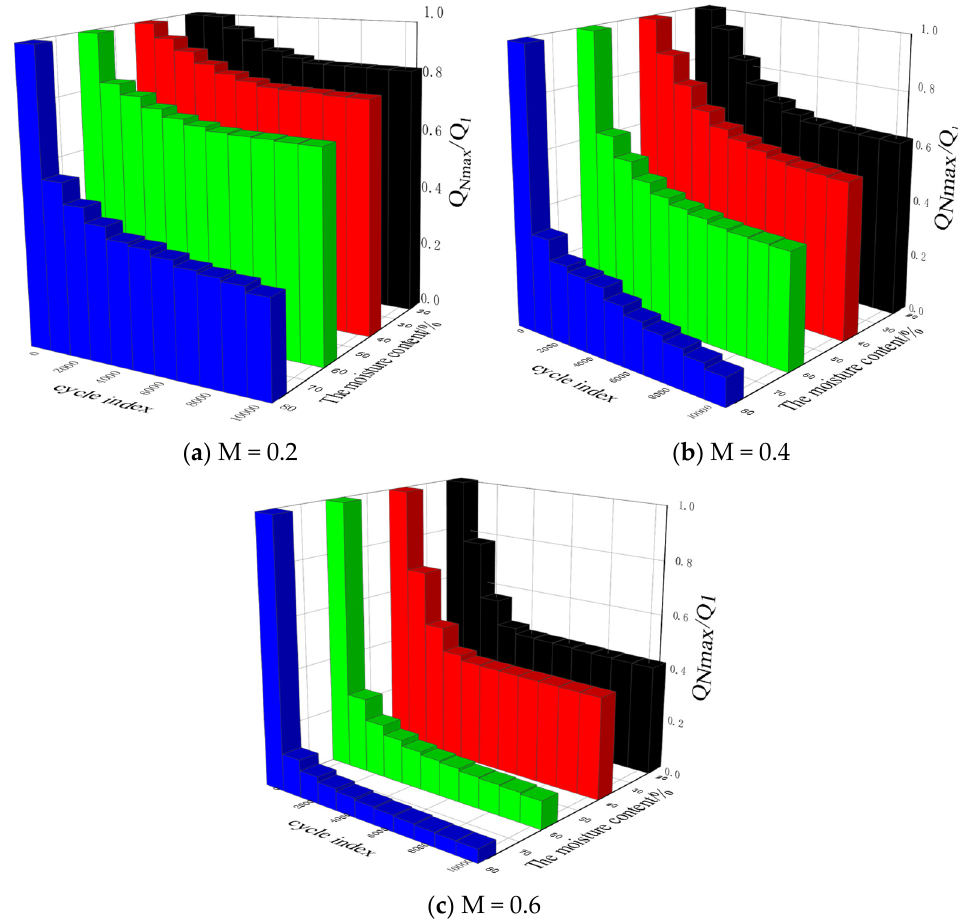
Figure 11. The variation in the pile lateral friction with the number of cycles under different water contents. ( a ) M = 0.2; ( b ) M = 0.4; ( c ) M =